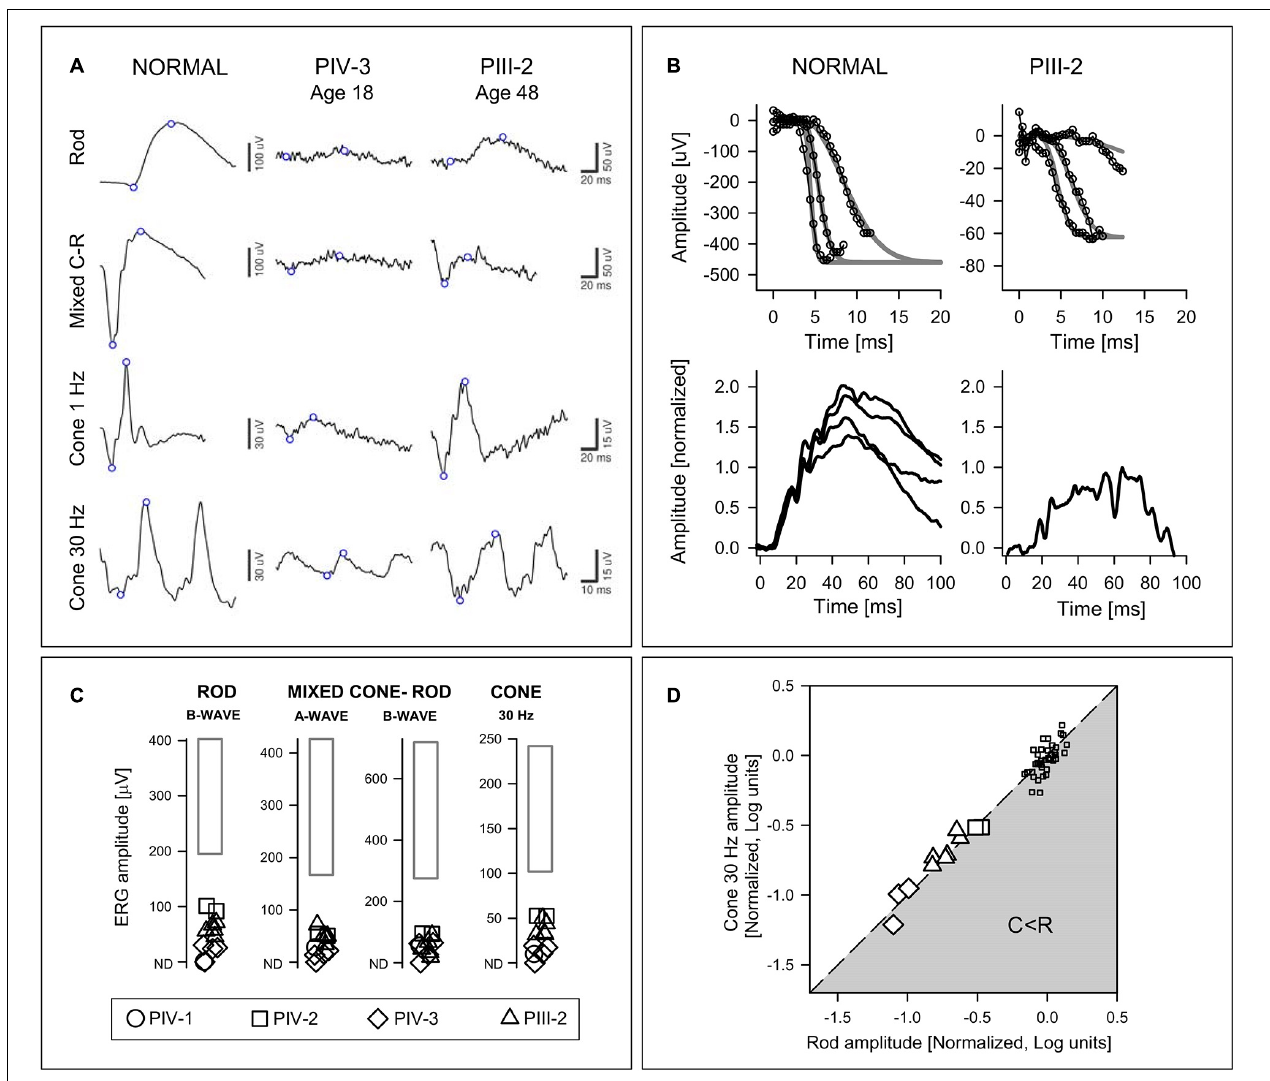
FIGURE 4 | Electroretinography in the ARL3 family members. (A) Rod, mixed (maximum white flash) cone-rod (C-R), and cone ERGs from a subject with normal vision, PIV-3 (age 18) and PIII-2 (age 48). Note the different vertical scales for Normal and Patients. There are larger amplitudes, albeit abnormal, in the father (PIII-2) and the mixed C-R waveform is “negative.” (B) P2 and P3 component analyses of rod-isolated ERG photoresponses. (Upper) Rod-isolated a-waves to different stimulus intensities in a normal subject and PIII-2. The smooth curves represent a family of functions describing phototransduction activation best fit to the leading edges of the intensity series. (Lower) Normalized rod P2 components in response to the 3.9 log scot · td · s intensity stimulus in four normal subjects, and in PIII-2. (C) ERG results from four family members compared with normal limits (rectangle: ± 2SD from the mean). (D) Relationship of rod b-wave amplitude to cone flicker amplitude. Amplitudes are normalized to mean normal values and expressed in log units. Line describes equal reduction of rod and cone amplitudes; gray zone represents greater cone than rod amplitude reduction (C < R). Patient data are larger symbols and small squares are data from normal subjects for comparison.